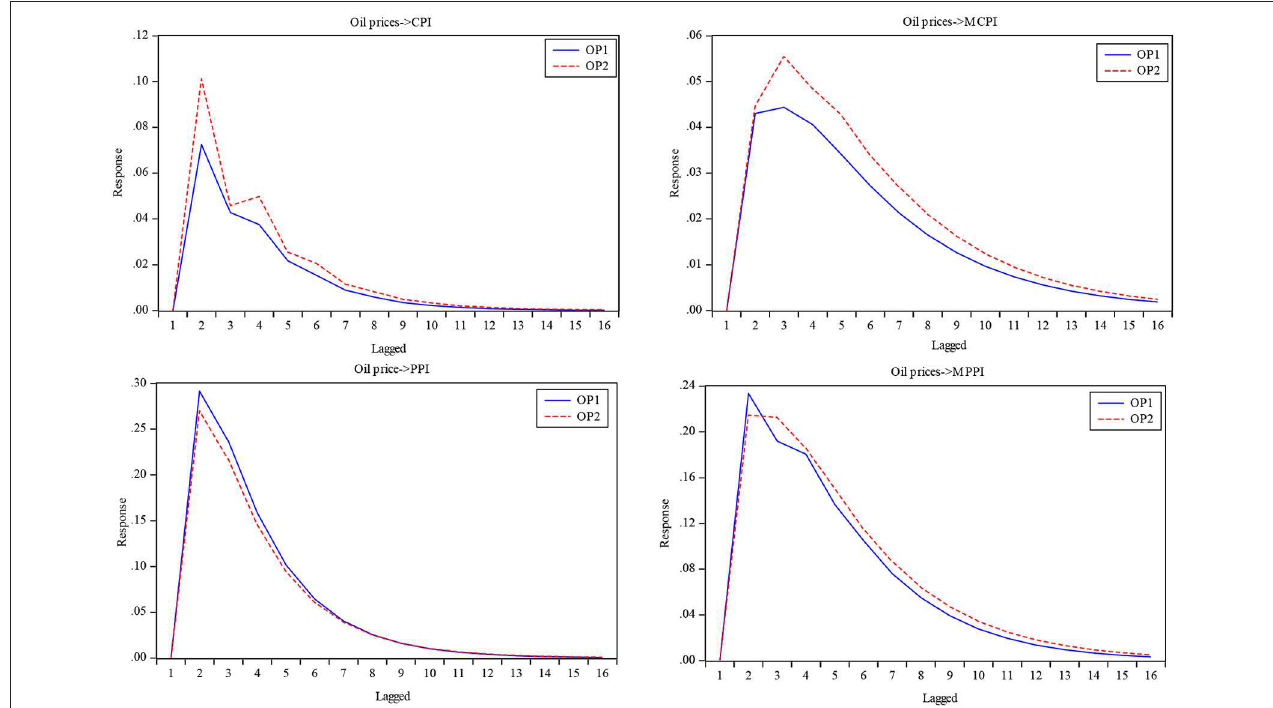
FIGURE 2 | The response of consumer/producer prices to oil prices with a monetary policy.